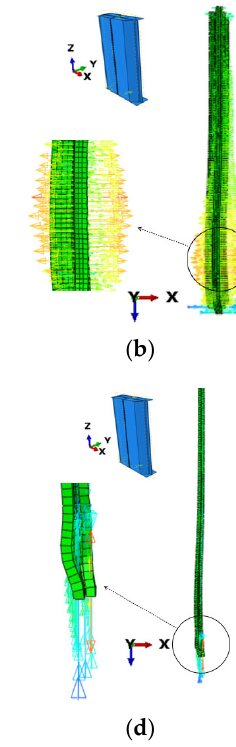
Figure 15. The complexity of the stress state at the welded corner. ( a ) Section view of the partial penetration welds after the initiation of the elephant foot buckling; ( b ) Circumferential stress component (S11); ( c ) Lateral stress component (S22); ( d ) Vertical stress component (S33).